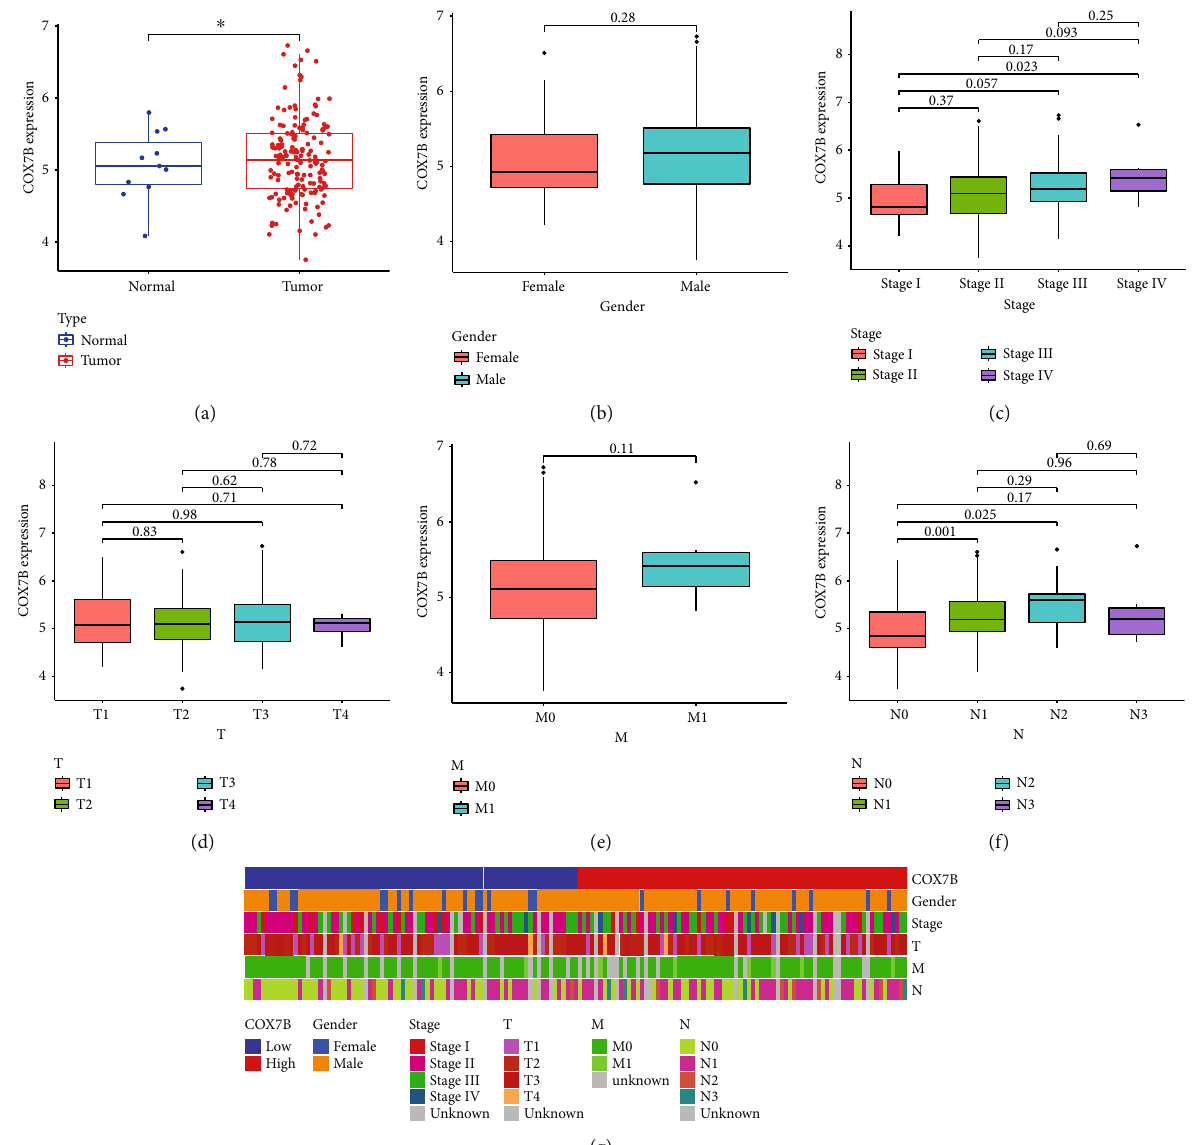
Figure 2: Correlations between COX7B expression in ESCA and clinical variables. (a) The distinct upregulation of COX7B was observed in ESCA specimens compared with nontumor specimens based on TCGA datasets. (b – g) Clinical features of ESCA and COX7B mRNA